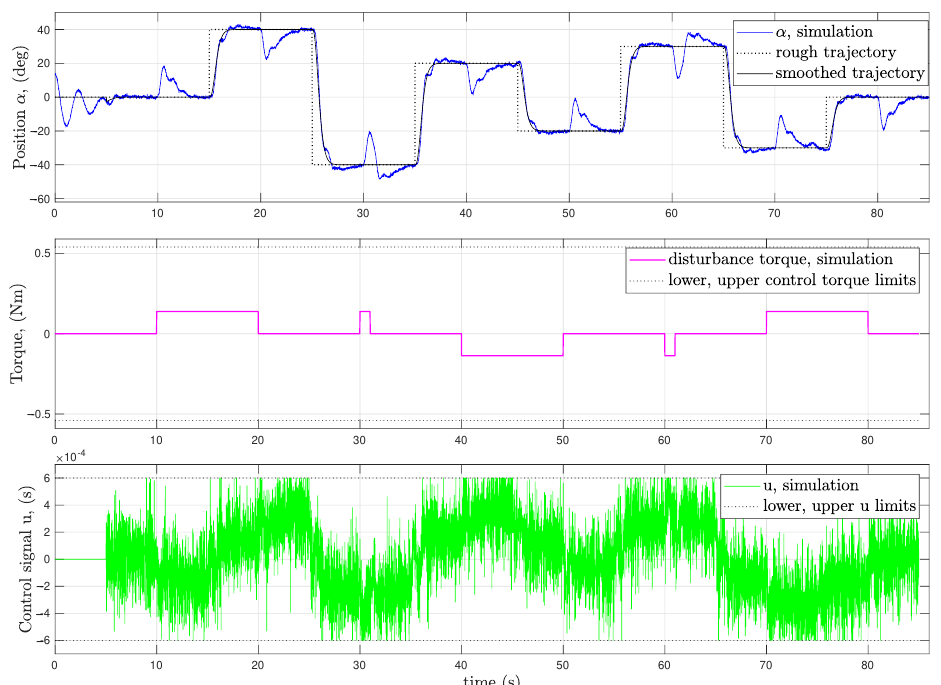
Figure 12. Trajectory tracking simulation in the presence of external torque disturbance, Λ = 2.25 s − 1 . To illustrate the magnitude of the disturbance torque, the minimum and maximum control torque levels that can be applied by the rotors are shown as dashed lines on the middle